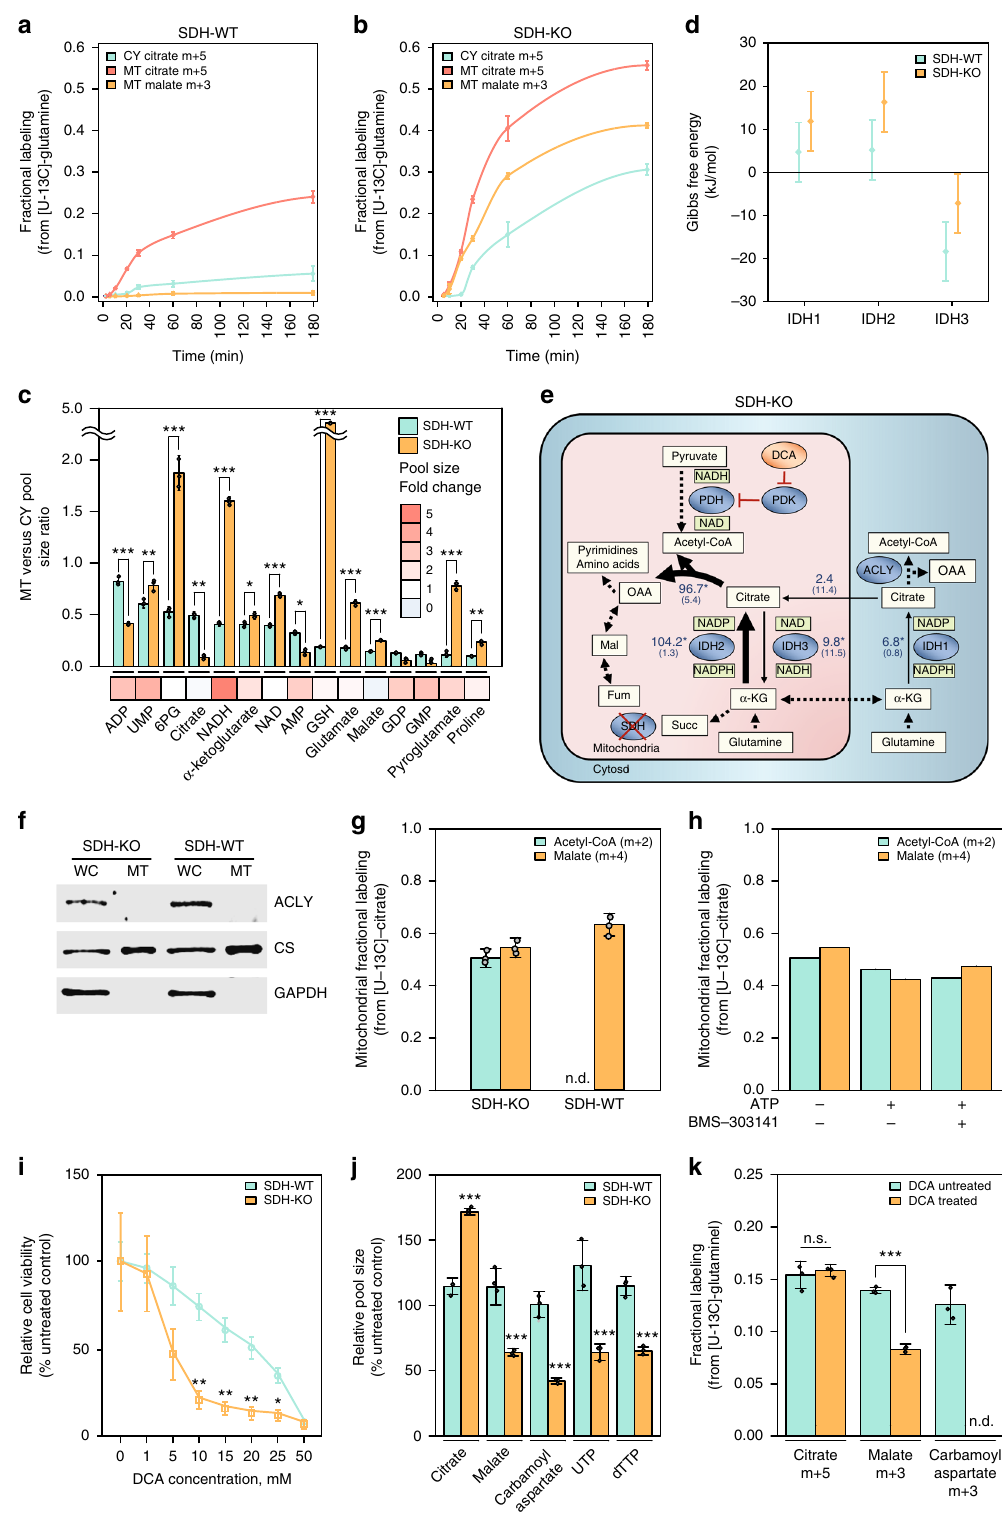
pyrimidine biosynthesis only in the SDH-de fi cient cells, as indicated by the signi fi cant drop in the concentration of malate, carbamoyl aspartate (an intermediate in pyrimidine biosynthesis), UTP, and dTTP only in these cells ( t -test p -values < 0.001; Fig. 5j). Consistently, feeding isotopic glutamine, we detected a signi fi cant drop in the m + 3 form of malate ( t -test p -value < 0.001) and